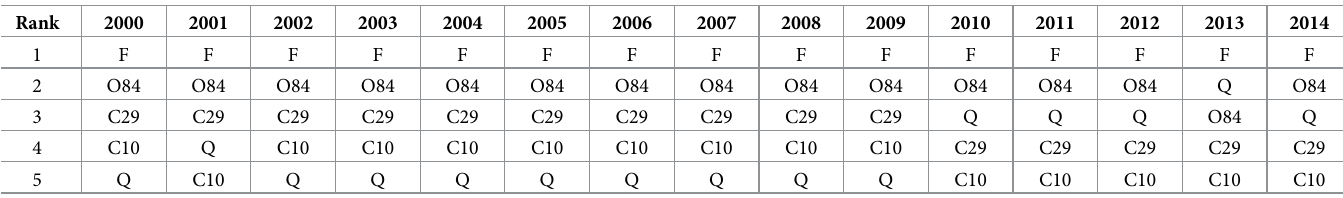
Table 12. Five lowest-potential sectors in the Pacific Rim community.